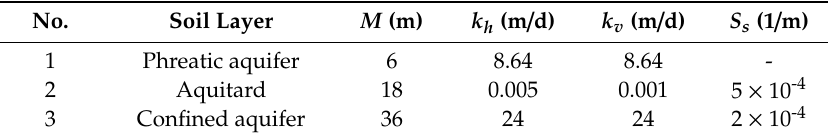
Table 2. Simplified parameters in the calculation